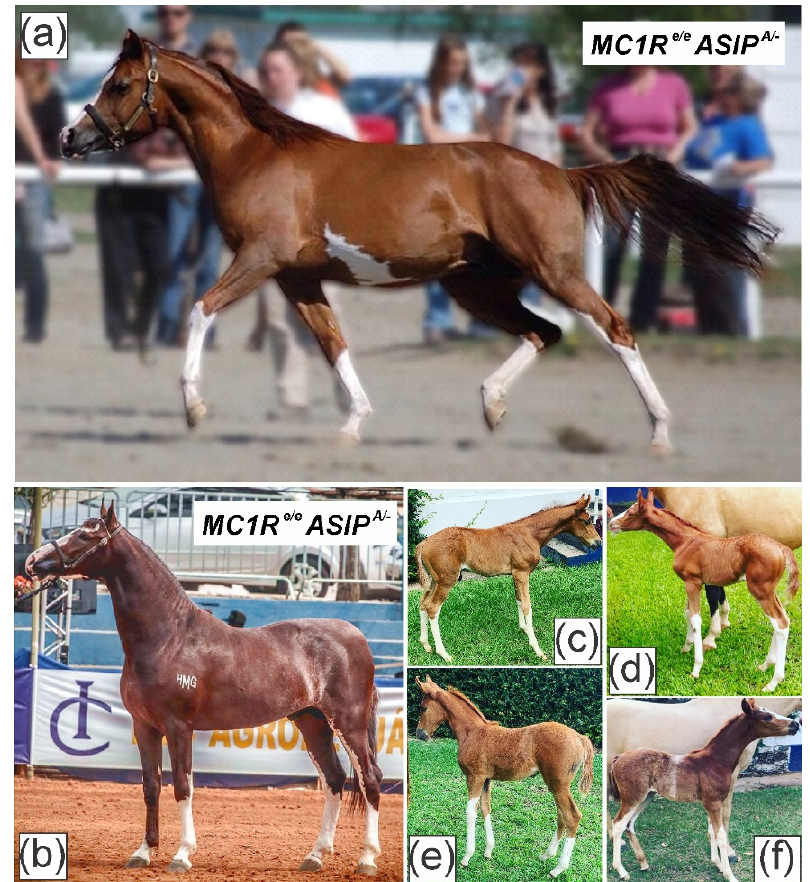
Figure 1. The subject stallions ( a , b ), demonstrating spotting phenotype extending past the distal part of the carpal and tarsal joints, as well as a facial white marking extending from the forehead to the upper and bottom lips along homozygote MC1R e/e phenotype, ( a ) also possess ventral white markings extending past the ribcage; ( c – f ) the respective offspring of the Mangalarga ( b ) stallion demonstrating the heritable phenotype.